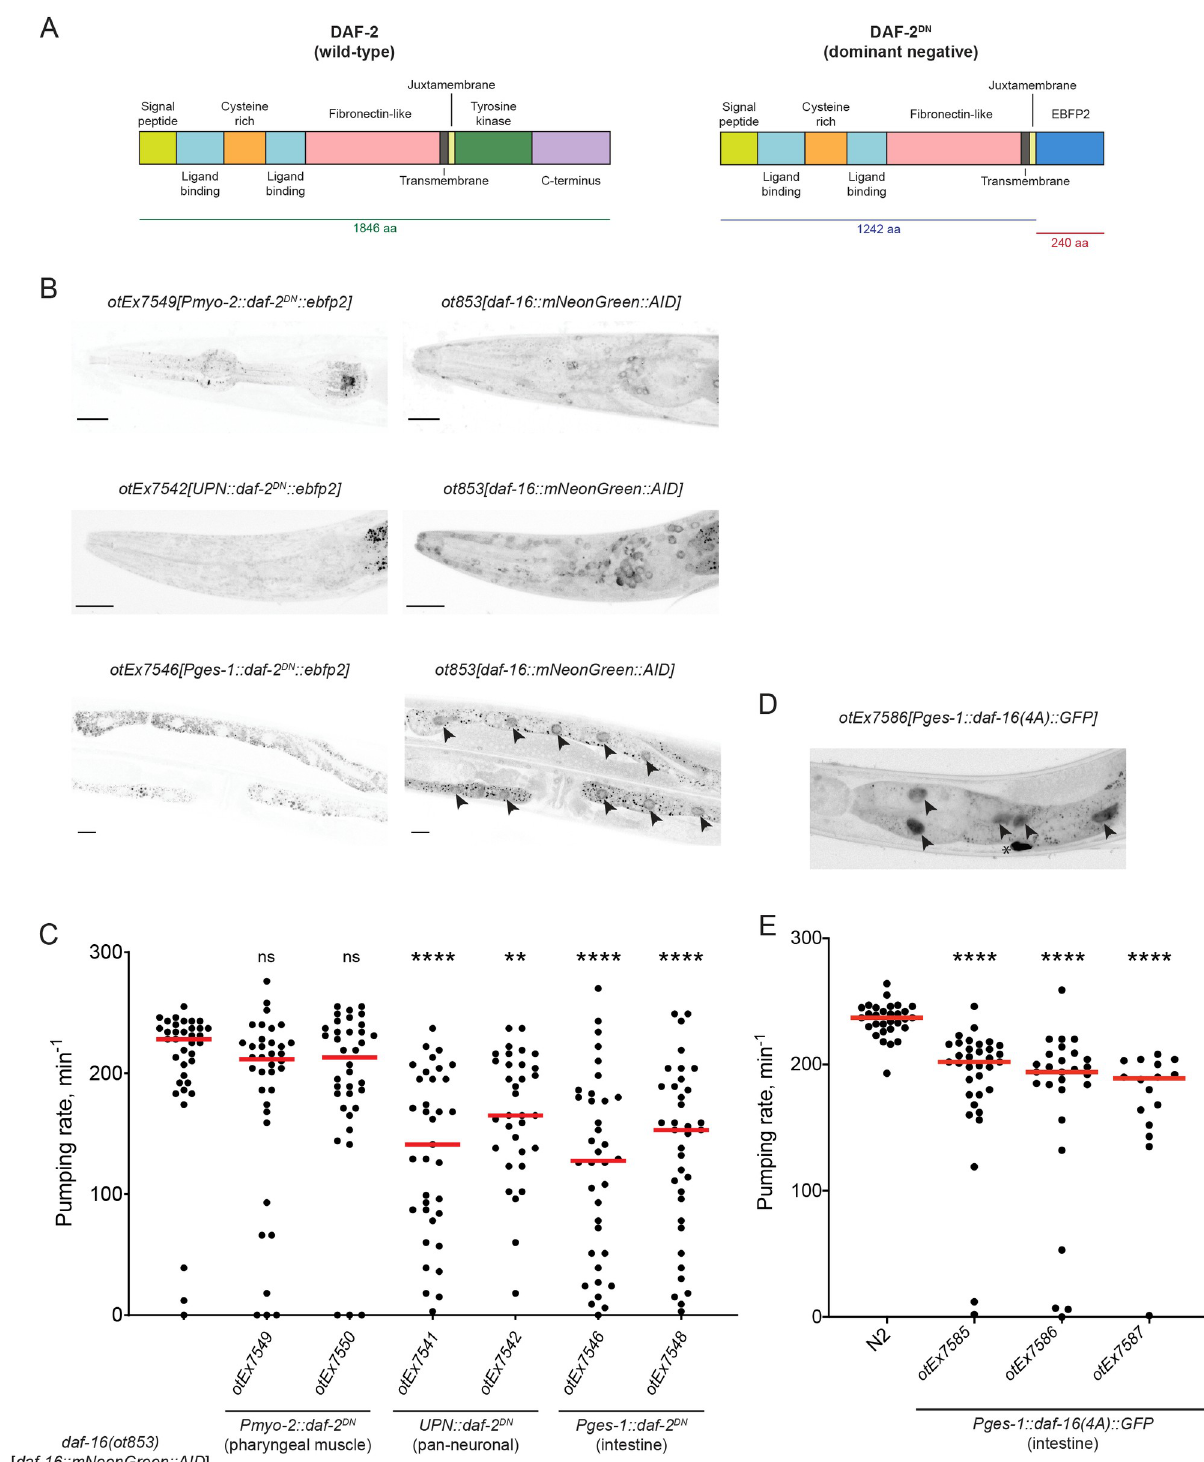
Fig 12. DAF-16/FoxO activation via inhibition of insulin signaling is sufficient to cell nonautonomously reduce pharyngeal pumping. ( A ) Schematic showing protein domains of wild-type DAF-2 (left) and DAF-2 DN , a dominant negative form of DAF-2/InsR in which the tyrosine kinase and carboxyl-terminal domains are replaced with the blue fluorescent protein EBFP2 (right). ( B ) Left panels: Expression of daf-2 DN :: ebfp2 in pharyngeal muscle (top), panneuronal (middle), and intestinal (bottom) tissues. Right panels: Localization of endogenously mNeonGreen-tagged DAF-16 protein